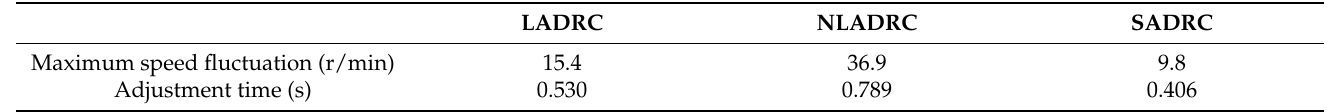
Figure 11. Experiment of the three control strategies under a step load of 1 N · m: ( a ) LADRC ( b ) NLADRC ( c ) SADRC. Table 4. Performance comparison of step load